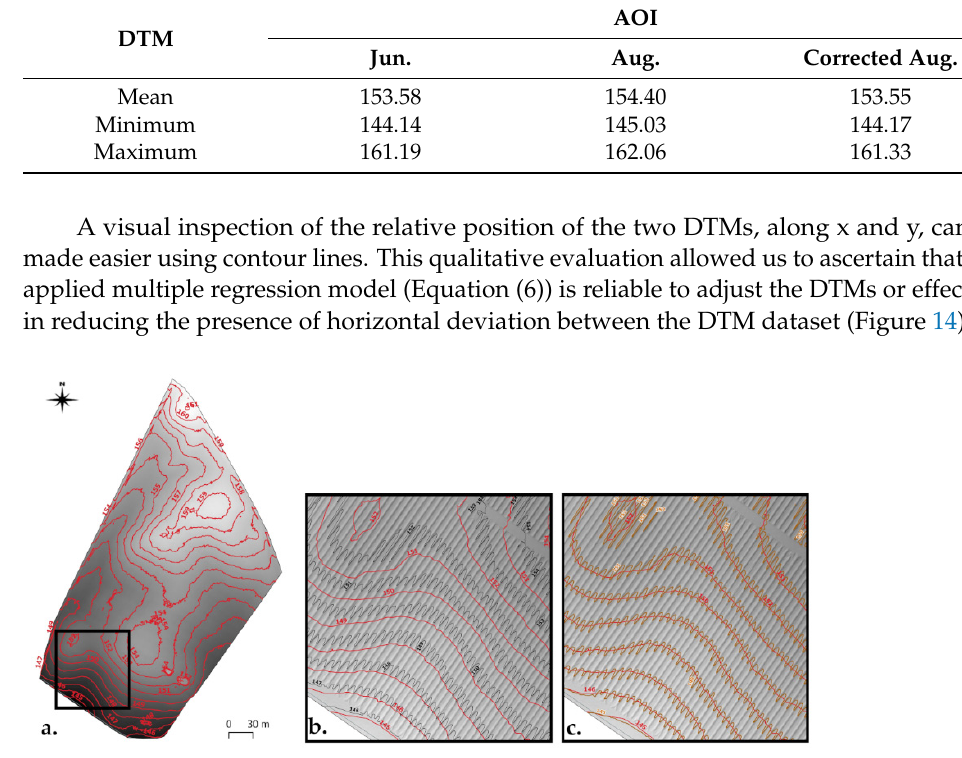
Figure 14. Contour lines (1-metre) derived from each DTM. June contour lines (JCL) ( a ); JCL and August contour lines (black line) overlaid ( b ); JCL and August contour lines derived from DTM corrected using model of Equation (6) (brown line) overlaid ( c ).